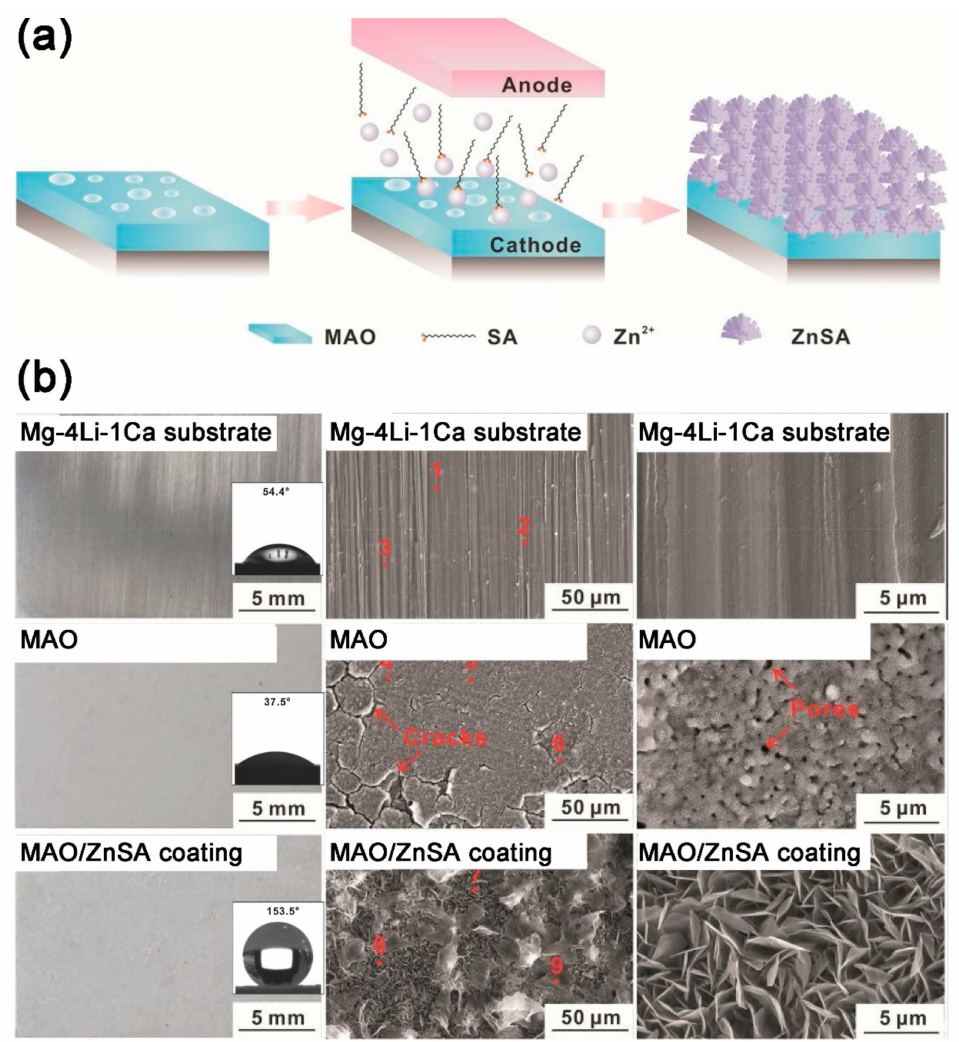
Figure 7. ( a ) Schematic of the electrodeposition process of MAO / ZnSA coating; ( b ) Macro-photographs and SEM images of Mg-4Li-1Ca substrate, MAO and MAO / ZnSA coating. The inserted are corresponding contact angles of each surface. Reprinted from [75]. Copyright (2017), with permission from